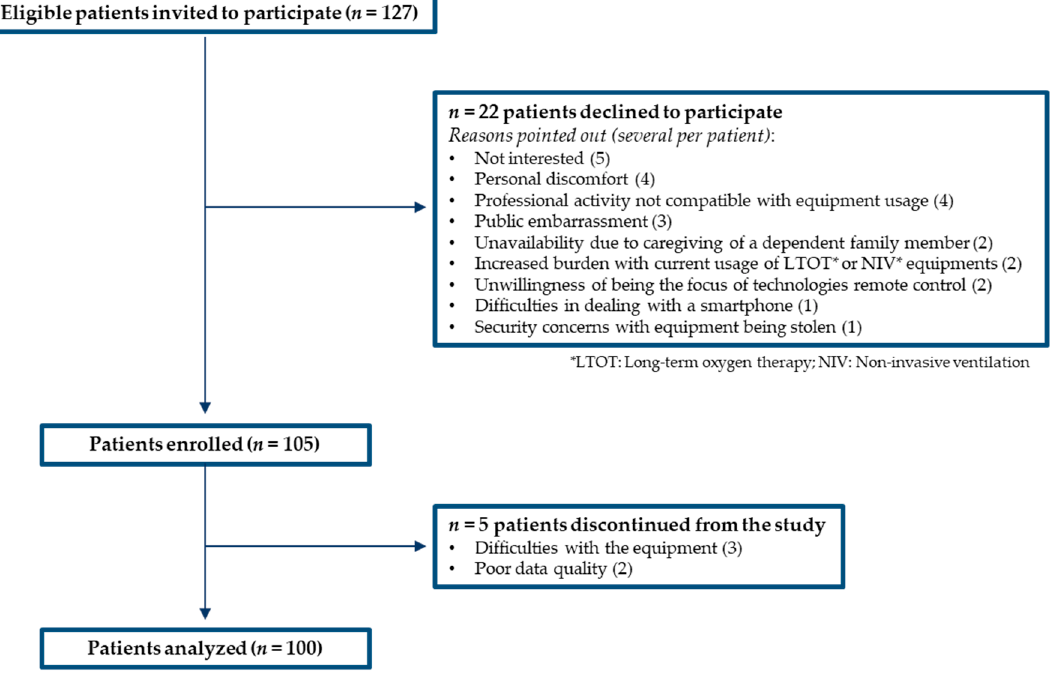
Figure 3. Enrollment flow diagram.